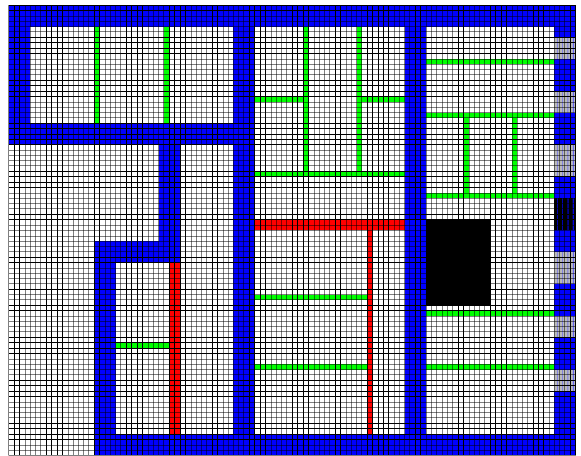
Figure 14. Second proposed subdivision schema for the adaptive reuse